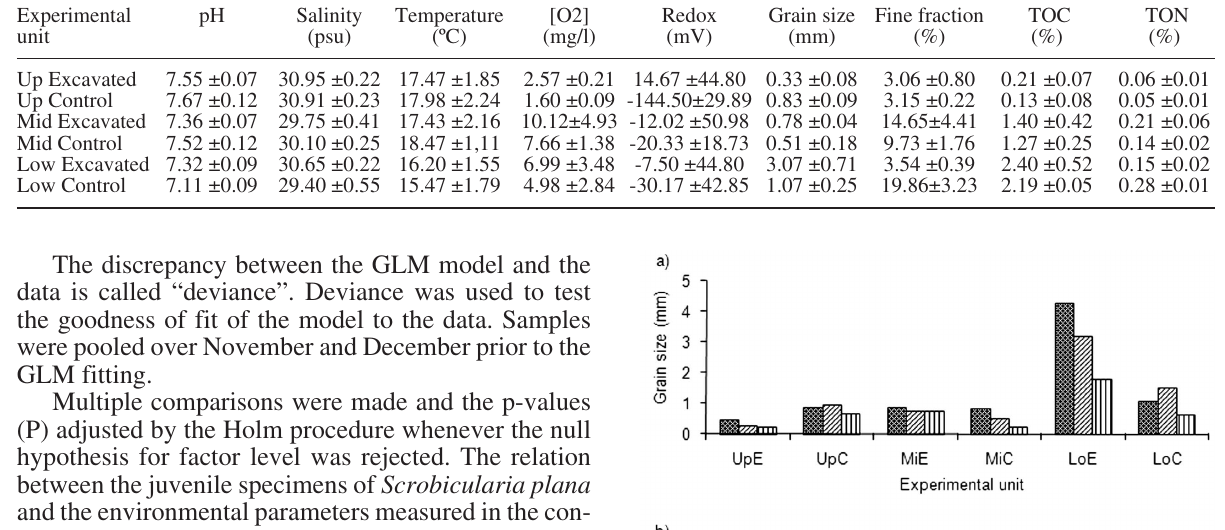
Table 1. – Physicochemical characteristics of the experimental plots pooled by months (and standard deviation) for each intertidal level (Up, upper; Mid, middle; Low, lower) and treatment (Excavated and Control). Experimental